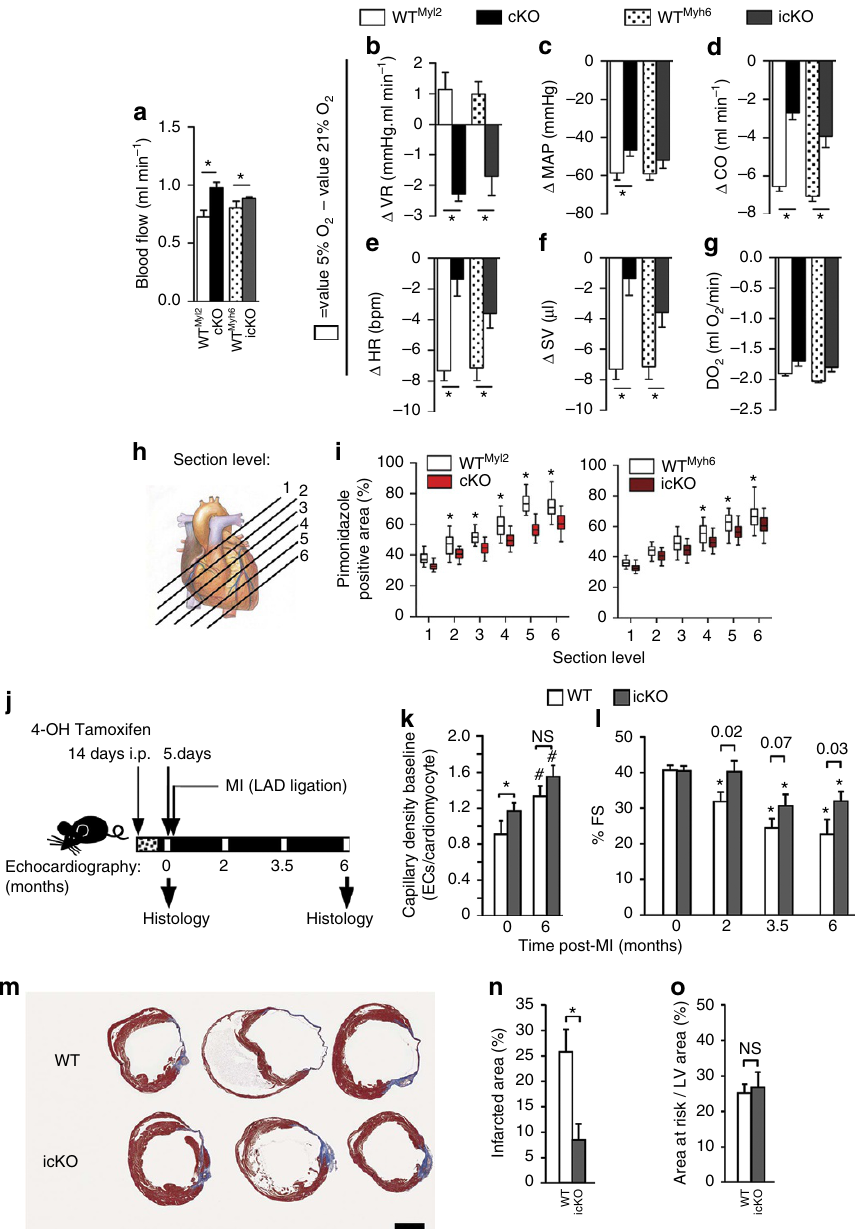
Figure 3 | Loss of RBPJ induces hypoxia tolerance and cardioprotection after MI. ( a – g ) Hemodynamic parameters. Blood flow at baseline ( a ) and hemodynamics upon hypoxemic challenge ( b – g ), plotted as value at 5 versus 21% inhaled O 2 in cKO and icKO ( Myh6 mER-Cre-mER/ þ , Rbpj fl /fl ) mouse lines relative to their respective genotype controls (WT Myl2 or WT Myh6 ). Parameters were VR ( b ), MAP ( c ), CO ( d ), HR ( e ), SV ( f ), and O 2 delivery (DO 2 ) ( g ). n ¼ 4; * P o 0.05 (ANOVA). ( h , i ) Tissue hypoxia quantified by pimonidazole detection in parallel histological sections, diagrammed ( h ). Apical sections (towards 6) had significantly smaller hypoxic regions in the cKO (left graph) and icKO (lower graph) hearts compared to their WT controls ( j ). Box represents mean and 25th and 75th percentiles; whiskers 5th and 95th percentiles. n ¼ 4 mice ( j ) Experimental protocol for MI. 4-OH tamoxifen was injected to induce recombination of the icKO at daily intervals during a 14-day window ending 5 days prior to LAD ligation (MI), followed by serial echocardiography and histological analysis at endpoint. ( k ) Microvessel density quantified 6 months after MI on histological sections. Capillary density was examined in the IVS, rather than the anterior wall, since the IVS was not damaged by the infarction. n ¼ 3, 4, 6, 6 for WT, icKO, WT þ MI, icKO þ MI, respectively. ( l ) LV fractional shortening (%FS) ( n ¼ 9 for each genotype and timepoint). P value between genotypes listed. * P o 0.05 respect to baseline same genotype. ( m , n ) Cross-sectional views ( m ) of WT and icKO hearts 6 months after MI and stained with Masson’s trichrome at the level of the papillary muscles. Quantification of the scar area ( n ) in infarcted myocardium (blue histological stain) expressed as a fraction of LV circumference from 3 parallel cross-sections spaced 700 m m apart ( n ¼ 6 WT and 7 icKO; see Methods section). Scale bar, 1mm. ( o ) LV hypo-perfusion (Area At Risk, AAR) determined by intravenous injection of FITC-ILB4 2-days post-MI and quantified on histological sections at the level of papillary muscles ( n ¼ 3 mice each genotype, see Methods section). Note that both genotypes showed comparably sized areas of hypo-perfusion. Data are means ± SEM. * P o 0.05; ns, not significant; n , biological replicates.